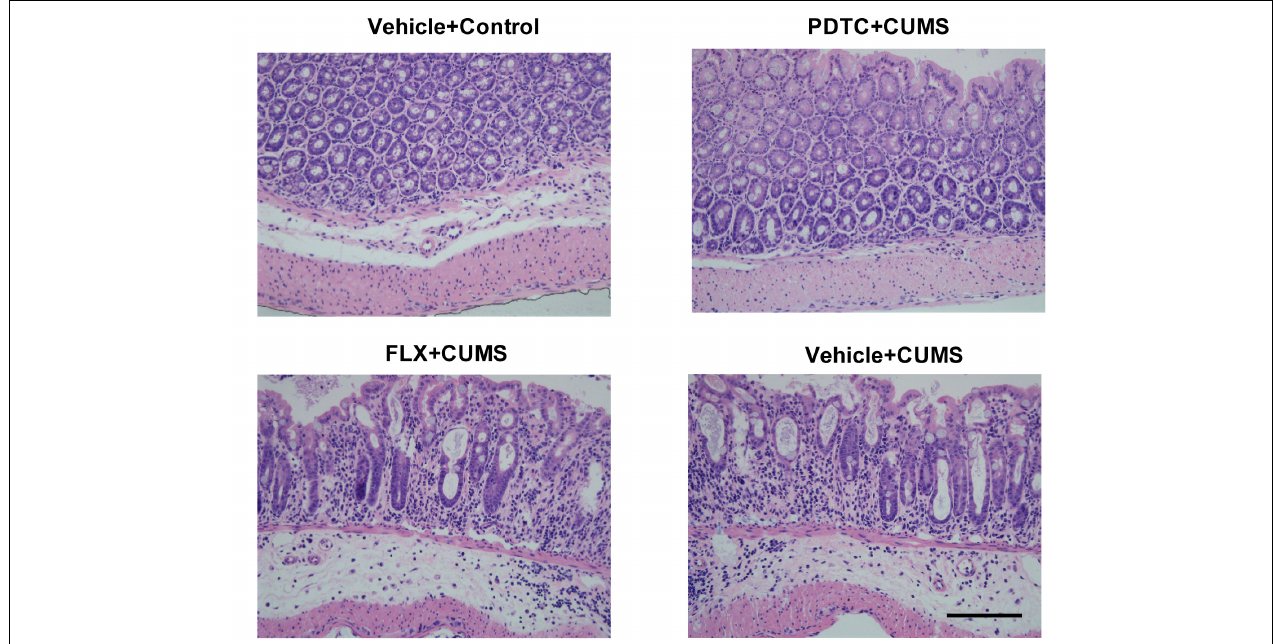
FIGURE 3 | Pyrrolidine dithiocarbamate pretreatment attenuated CUMS-induced colonic tissue damage in rats. HE staining showed that CUMS caused severe cellular damage and crypt necrosis in colon tissues, which could not be rescued by fluoxetine pretreatment. However, PDTC pretreatment could significantly attenuate CUMS-induced colon tissue